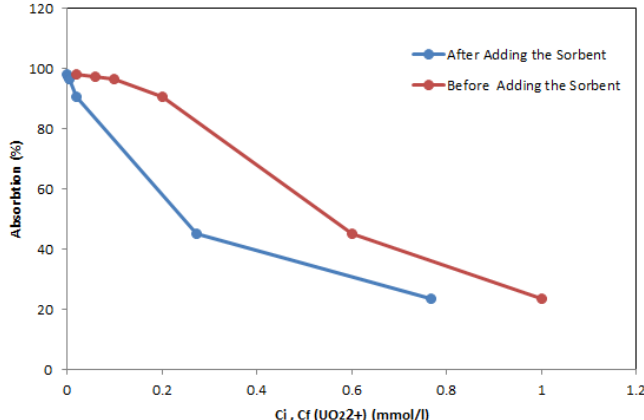
Fig. 12. Equilibrium sorption of uranyl ions by immobilized SC yeast adsorbent as a function of the initial concentration (before adding Fig. 12 . the adsorbent) and the final concentration of the uranyl ion (after adding the adsorbent) in the solution